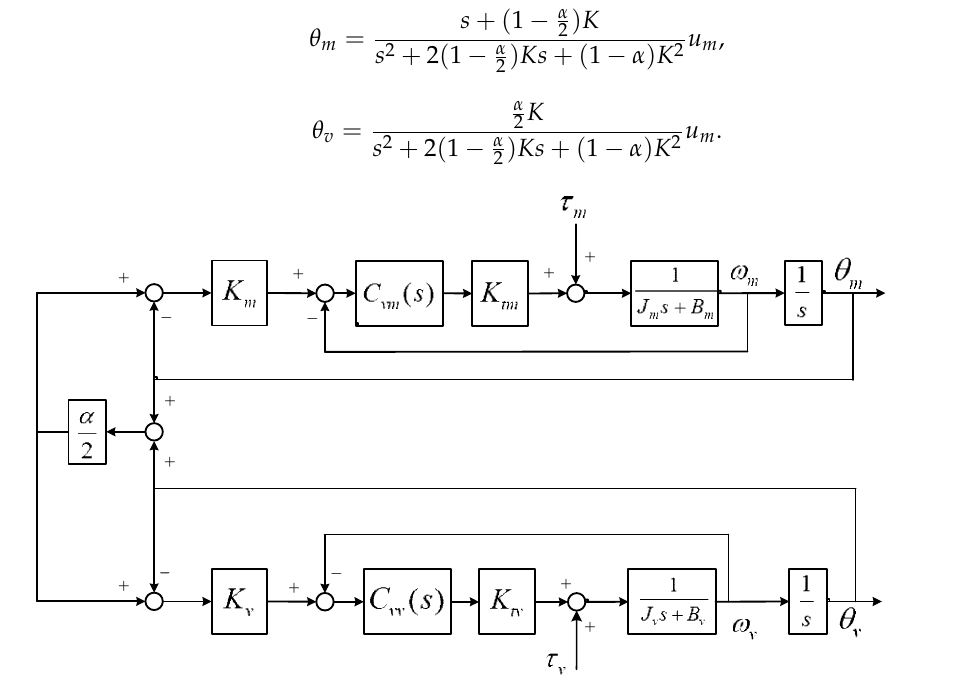
Figure 3. The internal position loop of bilateral control system.